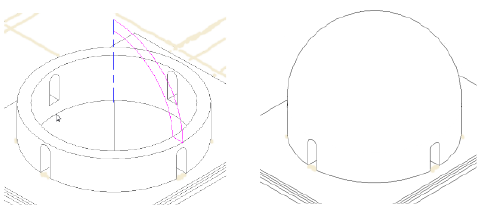
Figure 10. Modelling of the dome above the bell tower.